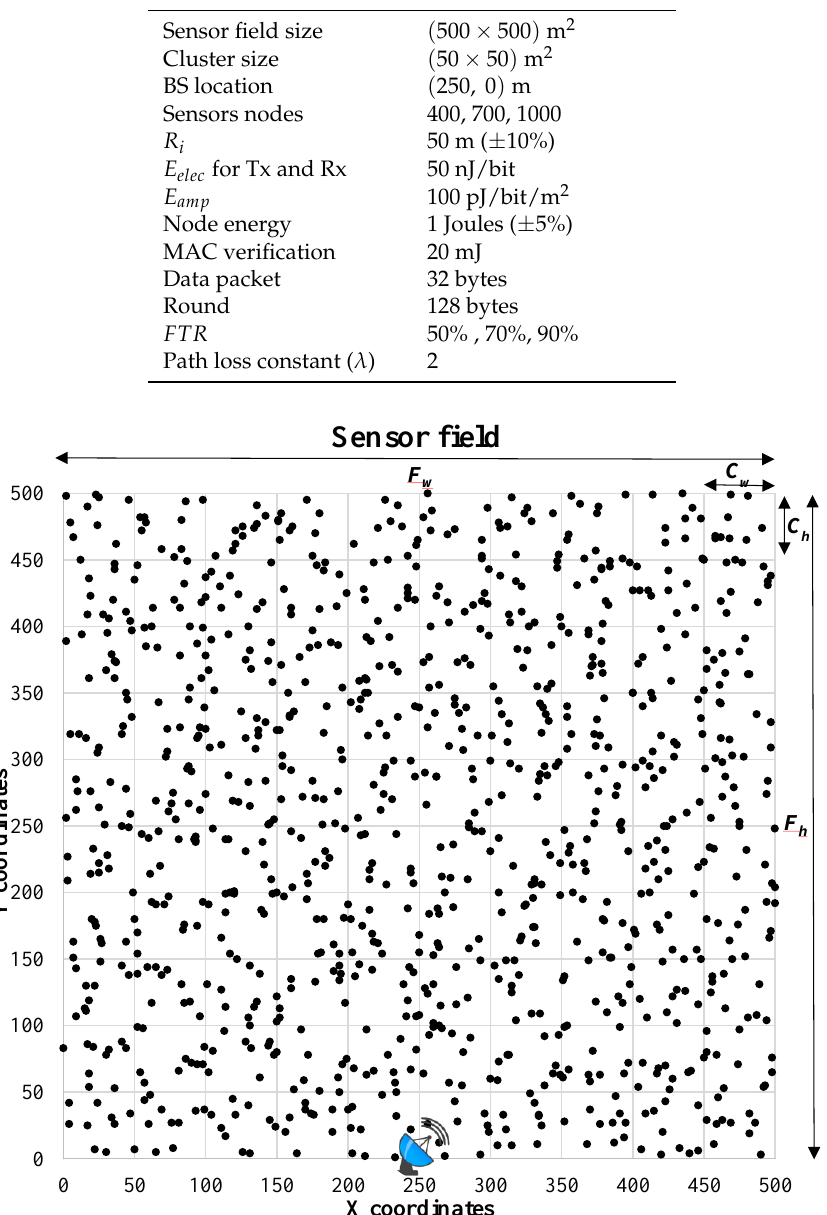
Figure 5. Square sensor field with the BS at the bottom